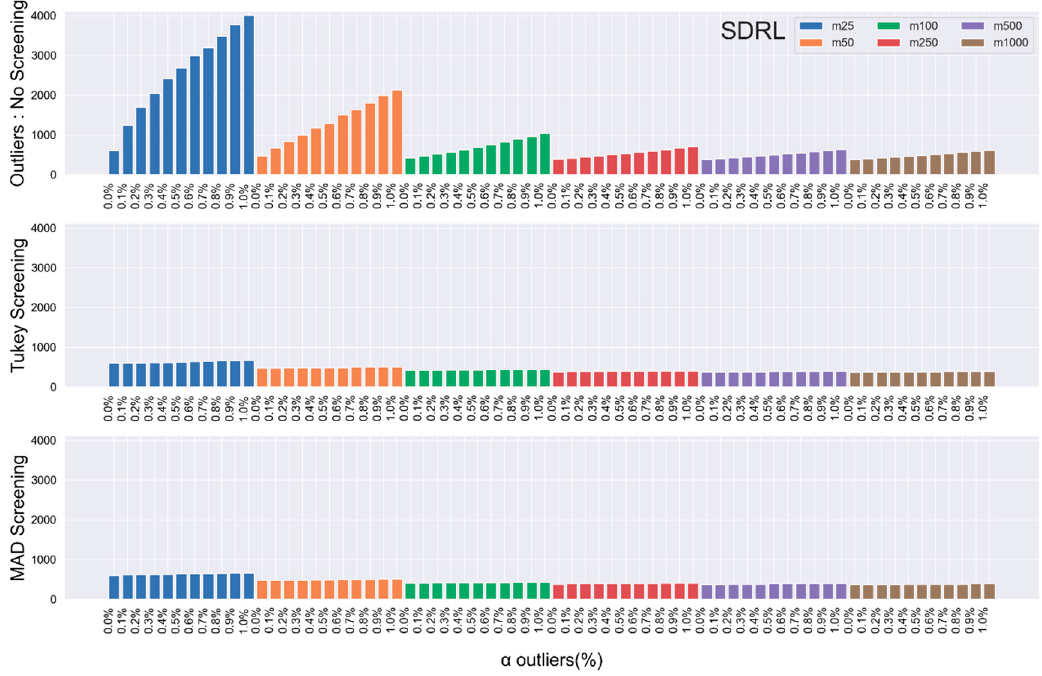
Figure 4. In-control SDRL values for the Shewhart chart from standard normal distribution in the presence of outliers with and without outlier screening.